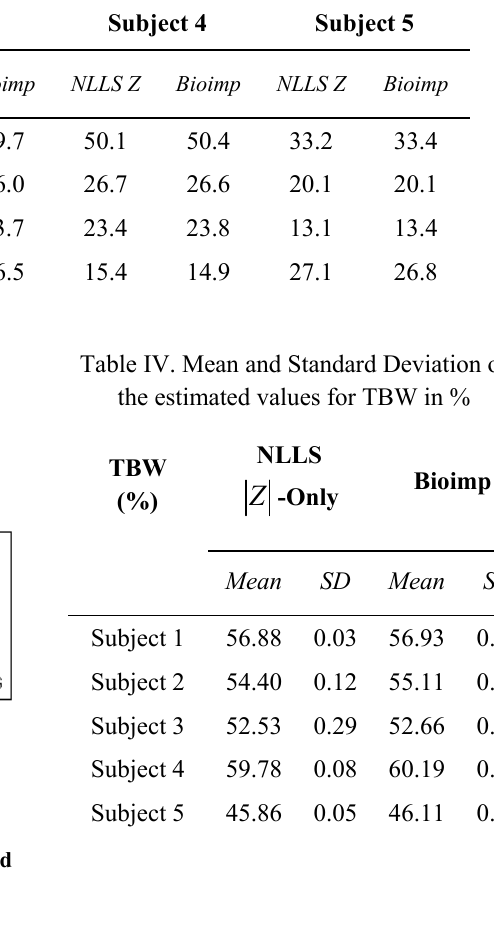
Table V. Mean and Standard Deviation of